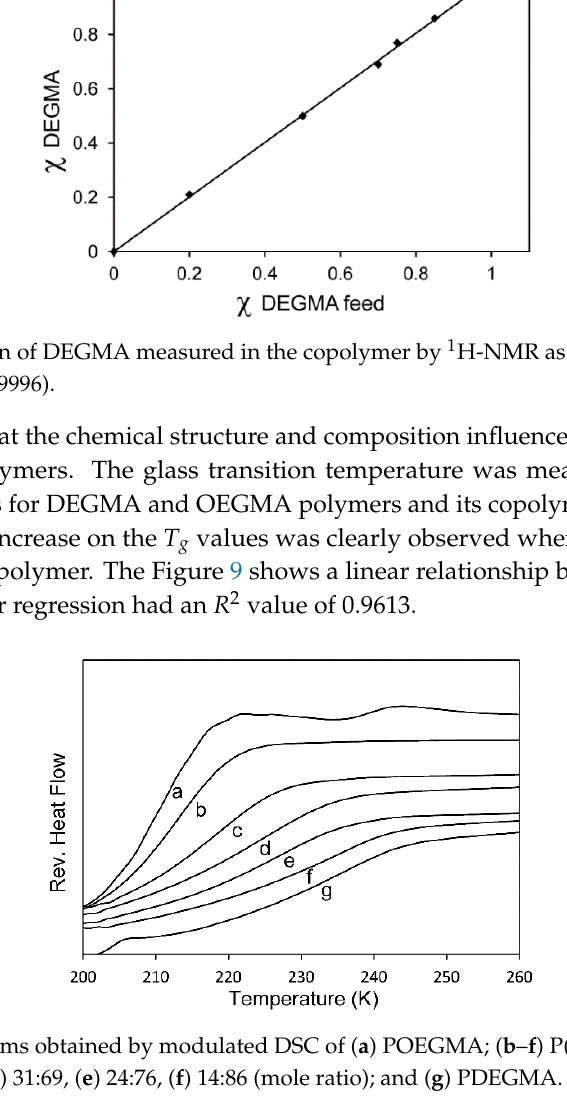
Figure 9. Glass transition temperature ( T g ) as a function of mol fraction of DEGMA in the copolymer ( R 2 = 0.9613).